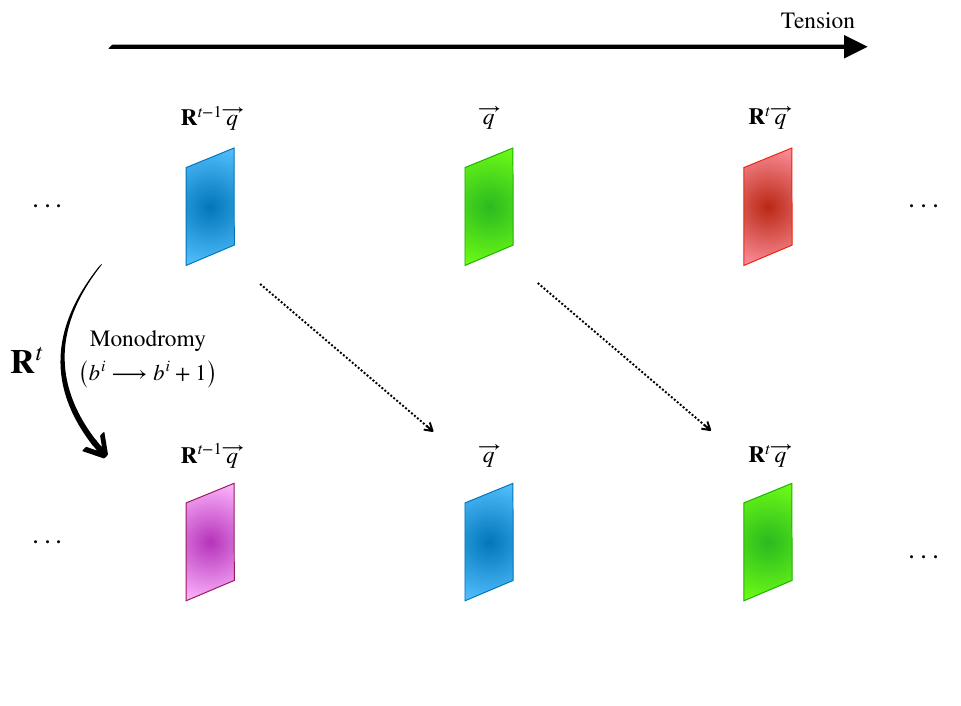
Figure 1. The monodromy maps some states into others with di(cid:11)erent mass and charge but the whole tower is mapped to